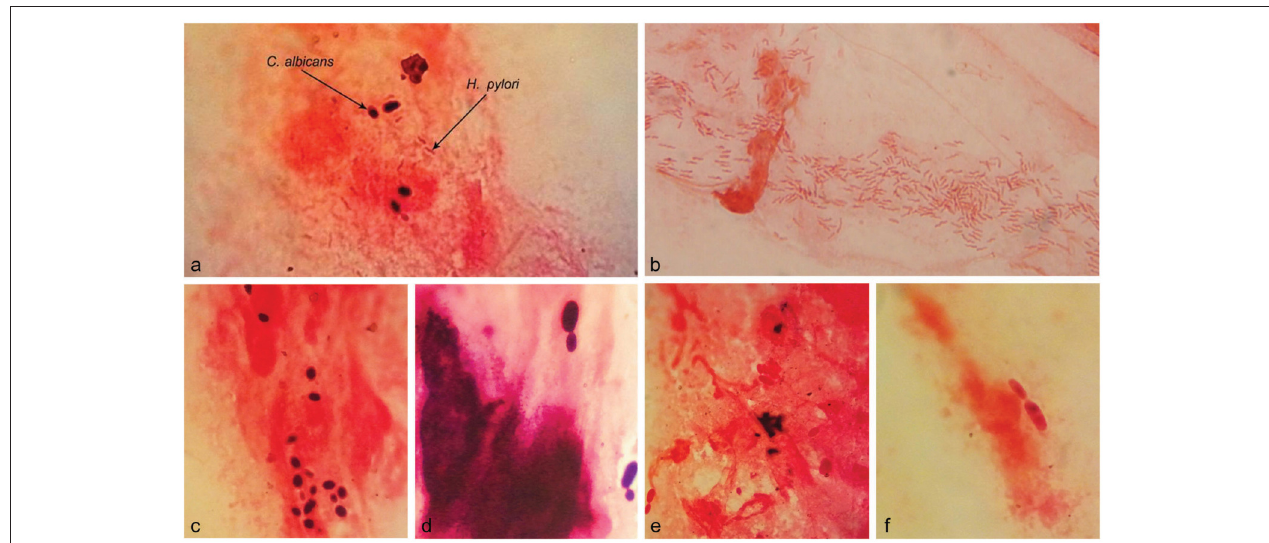
FIGURE 2 | Microscopic observation of H. pylori and Candida yeast in the Gram-stained smears of gastric biopsies from patients with gastritis. The Concurrence of H. pylori and Candida yeast cells (A) . The spiral cells of H. pylori (B) . Yeast cells; Gram positive (C) or Gram-negative (E) and some in the stage of budding (D,F) . Original magnification: X